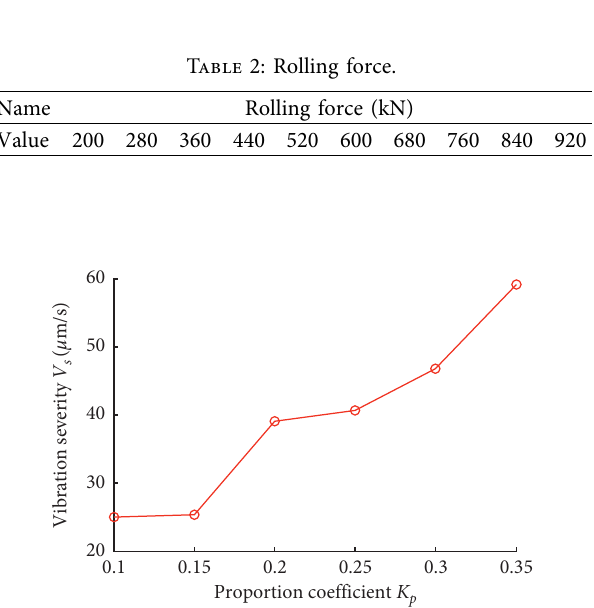
Figure 14: Variation curve of vibration severity under different proportion coefficient.